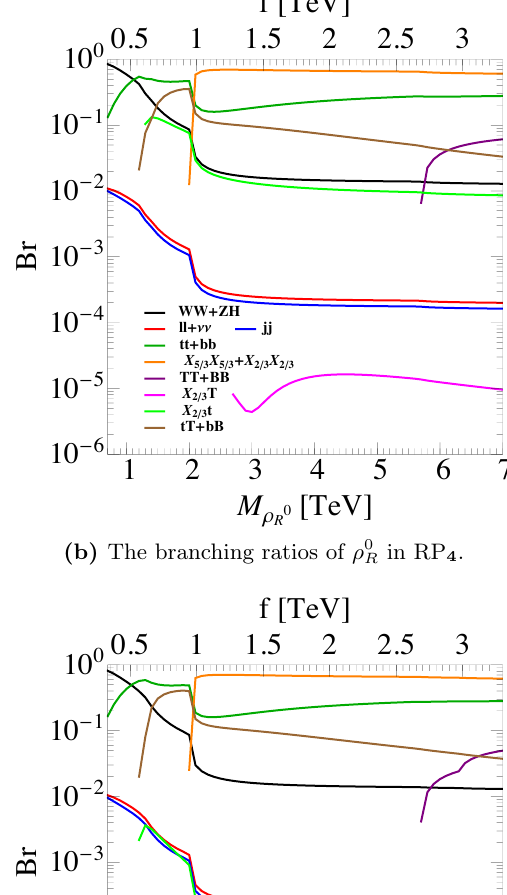
mainly decays into di-boson channels W + h + W + Z . R (cid:22) b channels dominate over (cid:22) t + X 5 = 3 2 = 3 and LF , 4 4 and below 10 (cid:0) 3 for model LF . In the 4 4